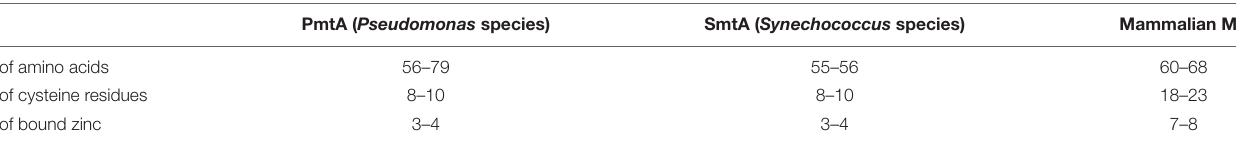
FIGURE 1 | Comparison of PAO1 PmtA and Homo sapiens Metallothionein I and generation valuation of the (cid:49) pmtA mutant. (A) MT from P. aeruginosa PAO1 contains 79 amino acids, 10 of which are cysteine residues. A comparison of human MT-1 (Accession: AAH29475) and PAO1 PmtA (Accession: NP_250830) using the BLAST online software reveals there is little homology between the sequences ( e = 6), but the alignment reveals many of the fully conserved regions (*, below sequence) are cysteine residues. A (:) indicates conservation of amino acids with strongly similar properties, while (.) indicates conservation of amino acids with somewhat similar properties. Cysteine residues that are conserved between MT-1 and PmtA are indicated by (*) above the sequence. (B) Confirmation of clean deletion mutant was revealed by colony PCR. Lane 1, shows a 100 bp ladder; lane 2, shows wild-type PAO1 (485 bp), and lane 3, shows the (cid:49) pmtA mutant (263 bp). (C) Overnight cultures of P. aeruginosa strains were grown in LB media for 24 h and total RNA was extracted from the cell pellets. Relative expression values for pmtA were calculated using the cycle threshold value compared to a standard curve for pmtA . pmtA expression was decreased in the (cid:49) pmtA mutant. This expression was restored in the complemented strain, (cid:49) pmtA:pmtA . One-way ANOVA analysis was performed (* p < 0.05; ** p < 0.01; *** p < 0.001; **** p < 0.0001). The data are presented as the average of three biological replicates ( ± standard error of the mean) and are representative of three separate experiments. TABLE 1 | PmtA comparison of Heavy metal binding characteristics and cysteine